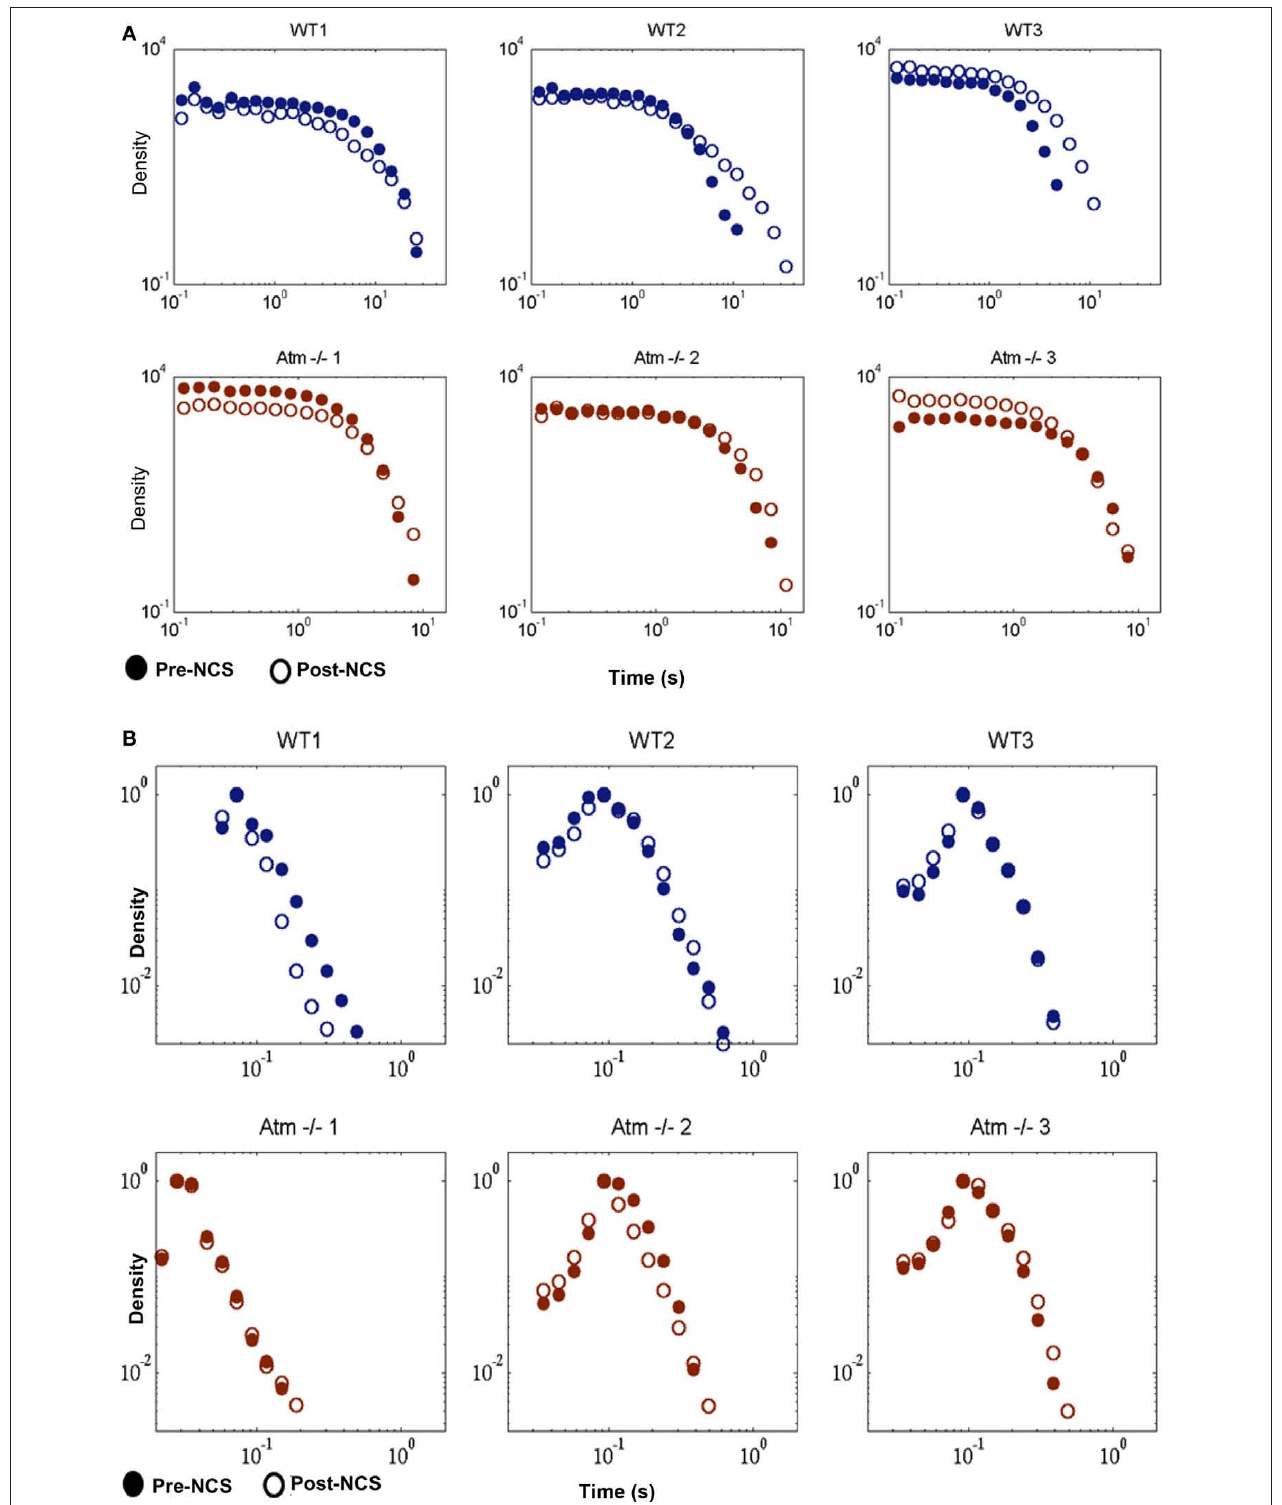
Figure 5 | inter-burst interval increments and burst widths in WT and Atm − / − cultures. (A) Delta Inter-Burst Intervals shown as a histogram with logarithmic binning. (B) Burst Widths shown as a histogram with logarithmic